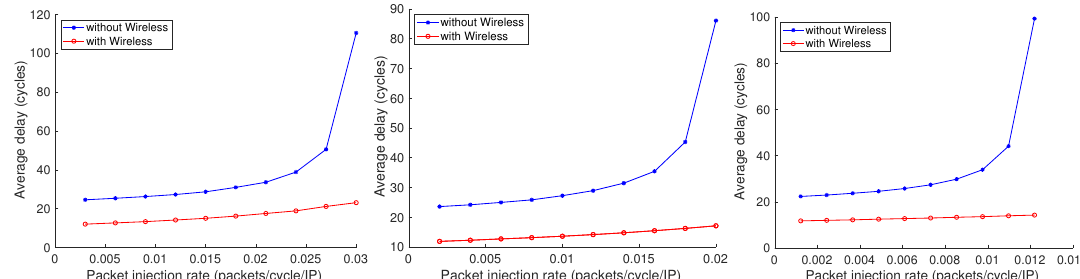
Figure 8. From left to right: Average delay for profiles T 4 , T 8 , and T 16 for 64 Mesh scenario and table-based traffic (TT-64